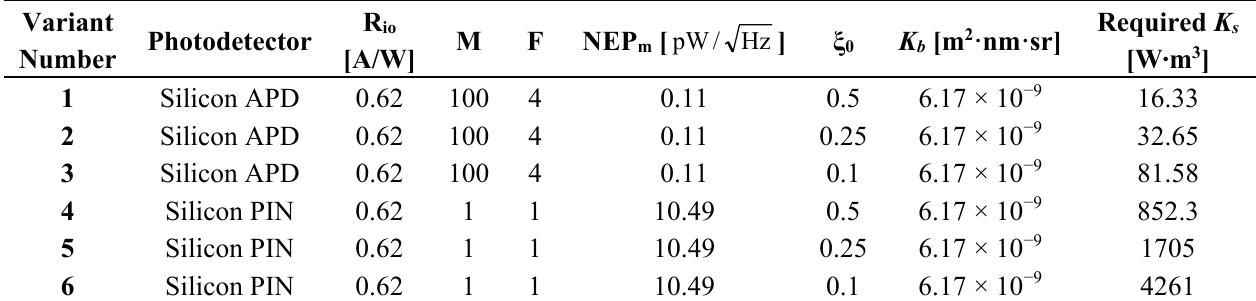
Table 2. Required system constant, K s , for various combinations of design parameters at 905